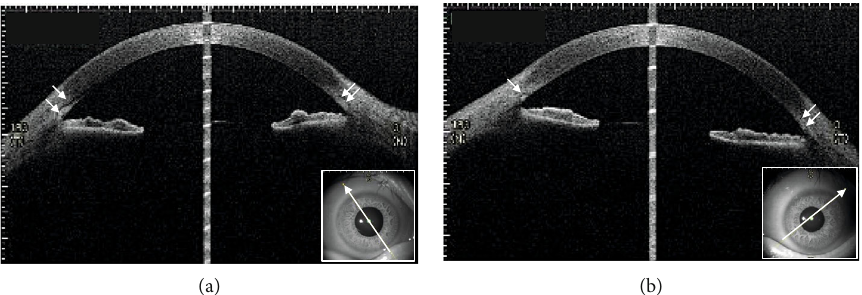
Figure 2: Anterior-segment optical coherence tomography images of the right (a) and left (b) eyes show posterior embryotoxon (arrows) and iris stromal atrophy.